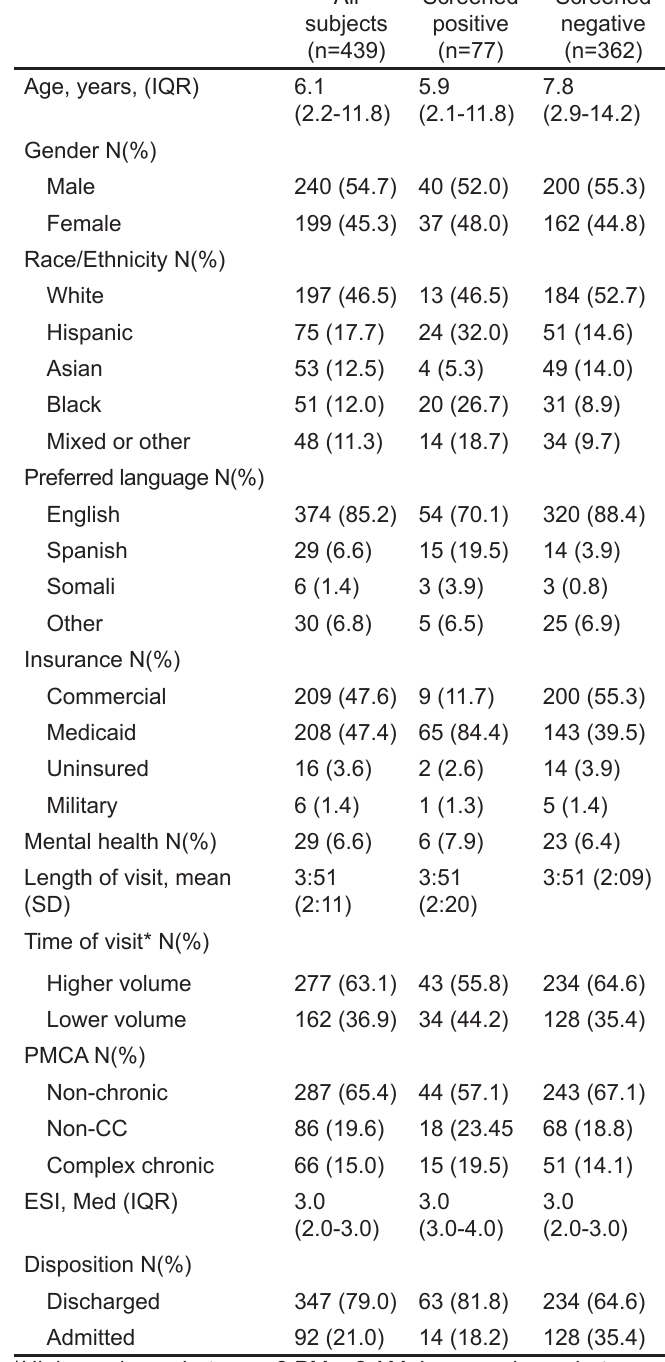
Table 1. Characteristics of pediatric patients screened for food